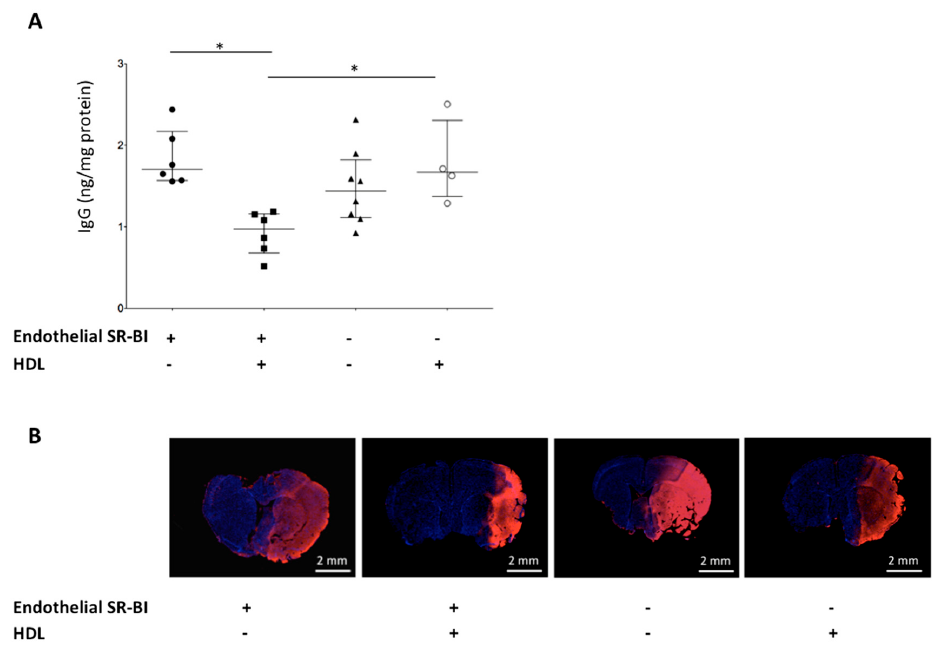
Figure 2. Role of endothelial SR-BI in the BBB integrity after AIS. ( A ) In SR-B flox/flox mice, intracarotid infusion of HDLs decreased extravasation of blood-borne immunoglobulins G across the BBB compared to saline infusion (* p < 0.05). The protective effects of HDLs on the BBB integrity were thwarted by the deletion of endothelial SR-BI in SR-BI flox/flox /Tie2-Cre mice (* p < 0.05). ( B ) BBB leakage was qualitatively assessed by blood-borne albumin extravasation into the brain parenchyma. Immunofluorescence staining of albumin (in red) on coronal brain slices 24 h after middle cerebral artery occlusion (MCAO) followed by reperfusion showed a smaller albumin positive area in SR-BI flox/flox (“endothelial SR-BI +”) mice treated with HDLs vs. saline. The deletion of endothelial SR-BI in SR-BI flox/flox /Tie2-Cre mice (“endothelial SR-BI − ”) did not prevent albumin extravasation after HDL infusion.